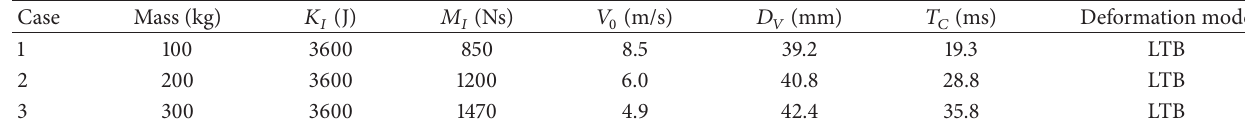
Table 4: Analytical results of momentum effects.